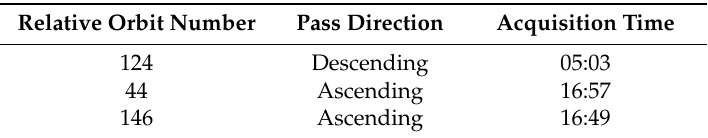
Figure 5. Comparison of the GEO SAR-like SM products, before (second row) and after (third row) the disaggregation process, against the corresponding maps of the TRUTH and OL model runs (first row). The maps must be considered as produced within the time-windows of eight hours in which the GEO SAR is expected to acquire data. The GEO-1 map, the TRUTH map and the OL maps refer to the same instant of time, generally defined t 1 . The GEO-2 map refers to the instants of time t 1 and t 2 . The GEO-3 map was instead generated by accounting the time instant ranging from t 1 to t 8 . Note that the white pixels in the maps correspond to the areas masked out to simulate the actual retrieval capability of a SAR system. Table 2. S1 data considered to simulate the POLAR SAR SM assimilation. The total number of S1 images that were acquired over the Cervaro River Catchment in the time period under investigation and used in the SM-AD exercise were 58.